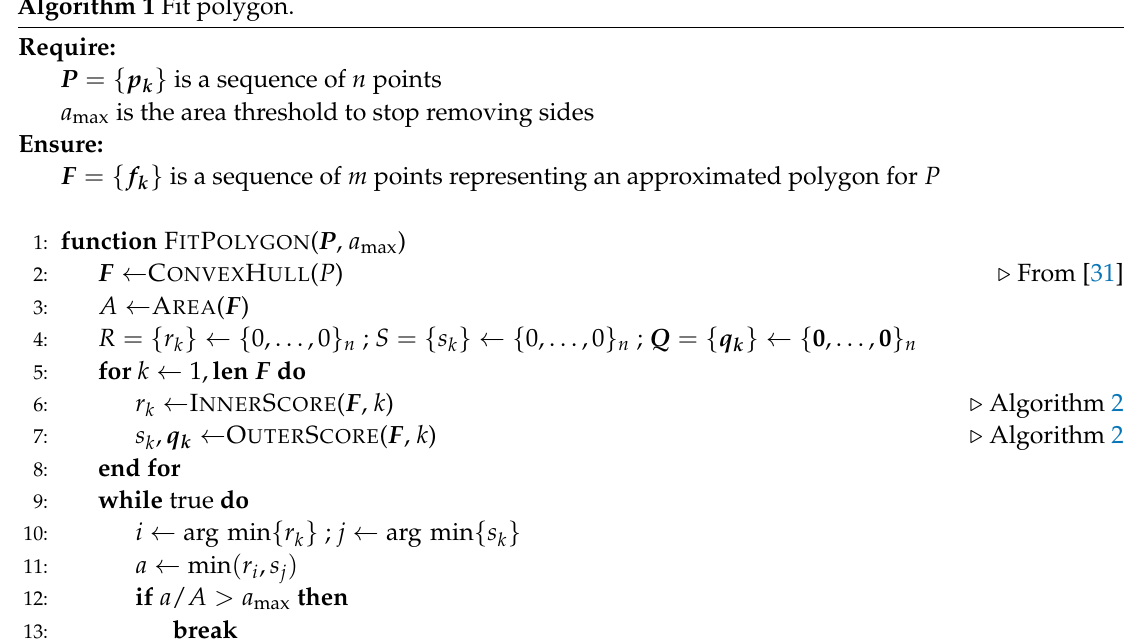
Algorithm 1 Fit